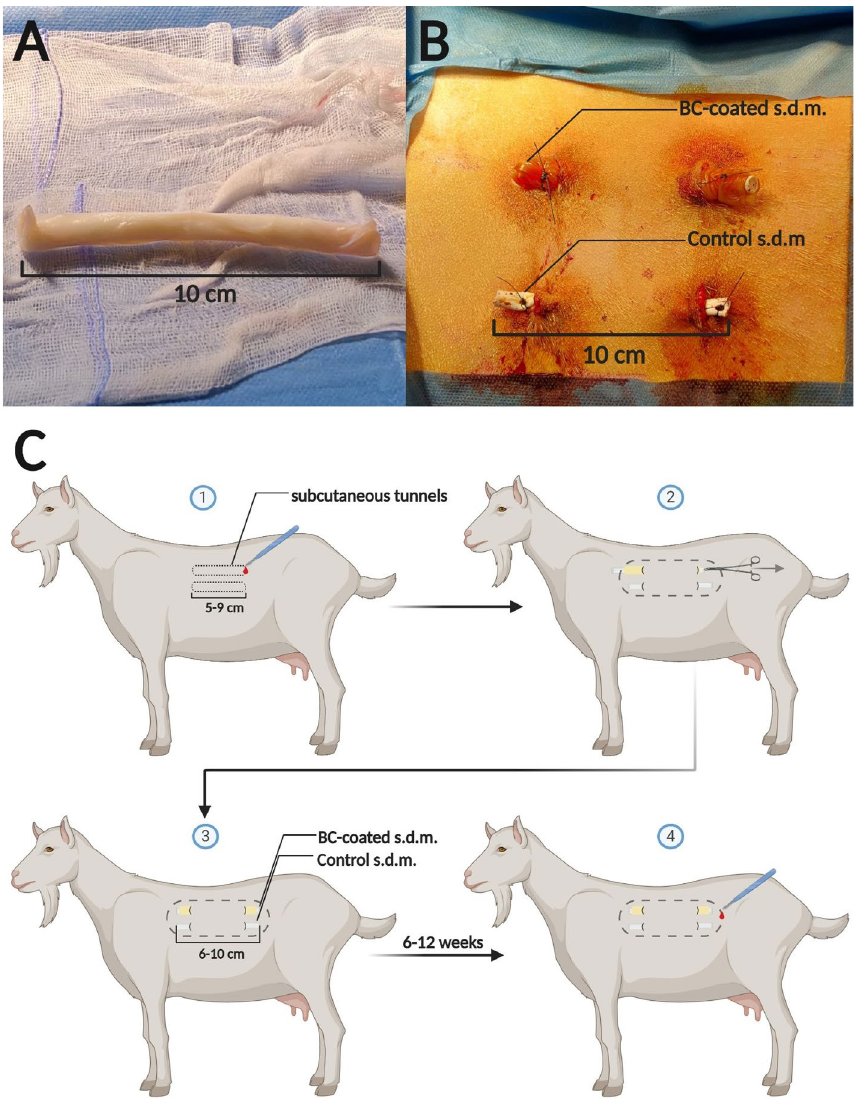
Figure 2. Application of biosynthesized cellulose (BC) to the silicone mantle (s.d.m) of L-VAD-drivelines and implantation process. ( A ) Original s.d.m. wrapped in BC. Both ends of overlapping BC were trimmed to the length of the s.d.m. ( B ) Surgical site at the end of the procedure. S.d.m. are secured at the exit sites by a single purse string suture. ( C ) Preparation of subcutaneous tunnels and insertion of s.d.m. Arrangement of implants at the animals flank. Dotted line represents future incision for the explantation of the